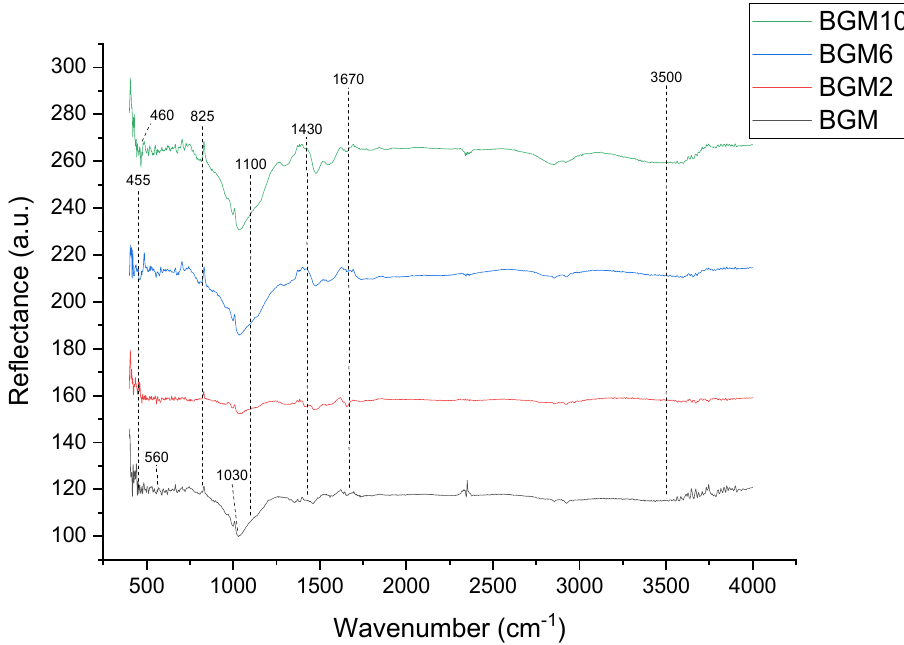
Figure 6. DRIFT spectra of BGM, BGM2, BGM6, and BGM10.